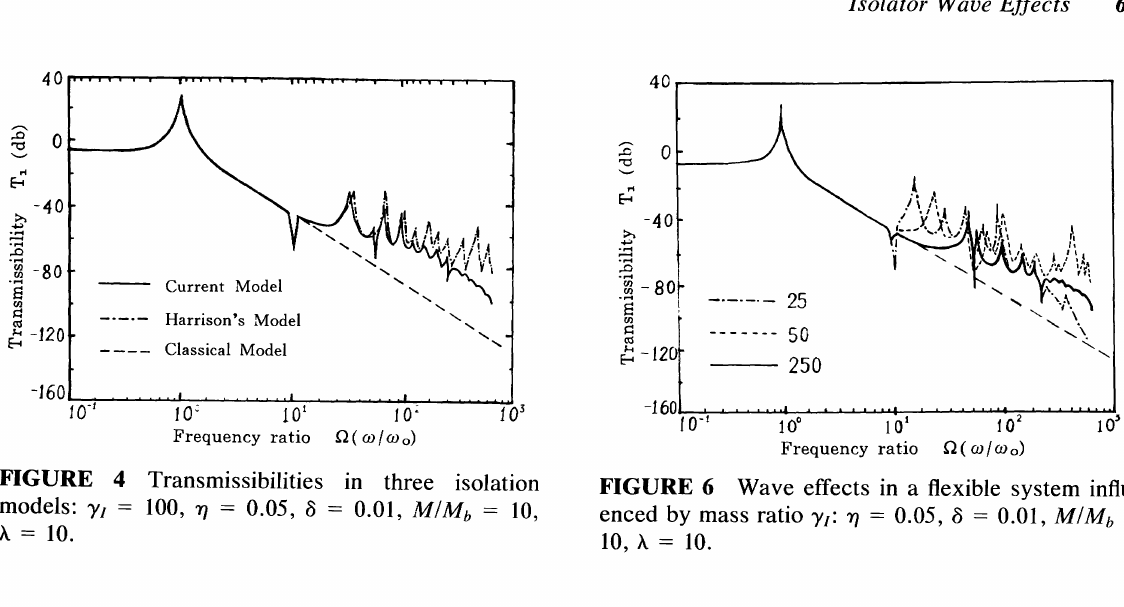
FIGURE 6 Wave effects in a flexible system influ enced by mass ratio 'YJ: 'YJ = 0.05, a = 0.01, M1Mb = 10, A = 10.